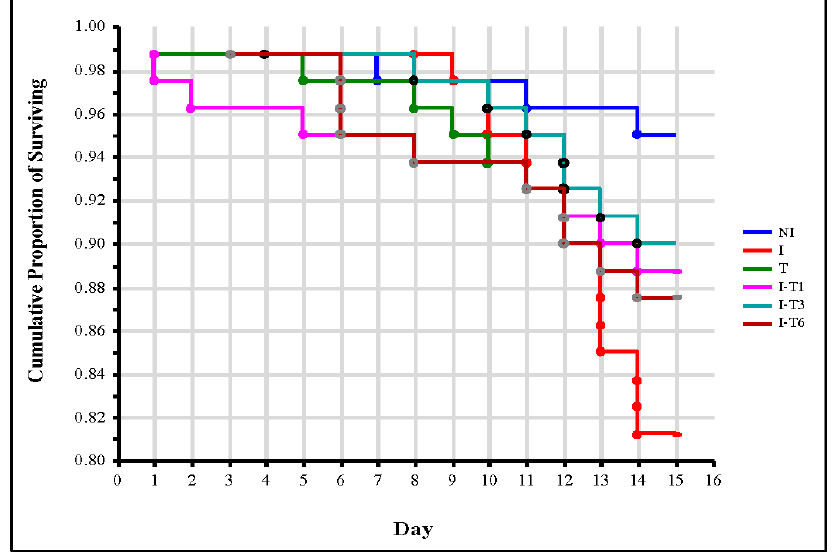
Figure 1. Survival curves of bees from control groups and from groups treated with thymol. Group infected with N. ceranae (I), group that was non-infected but treated with thymol (T), groups infected with N. ceranae and treated with thymol from day 1 (I-T1), day 3 (I-T3), and day 6 (I-T6), and non-infected (NI) group. According to the Mann–Whitney U test, no significant differences ( p > 0.05) between